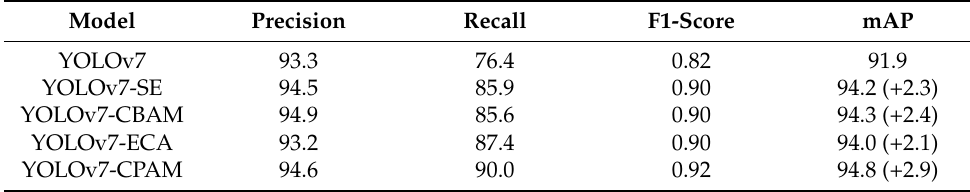
Table 8. The results of YOLOv7 with different attention modules.